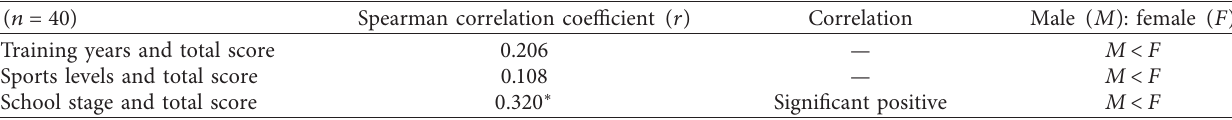
Table 4: Summary of correlation analysis between different variables and total